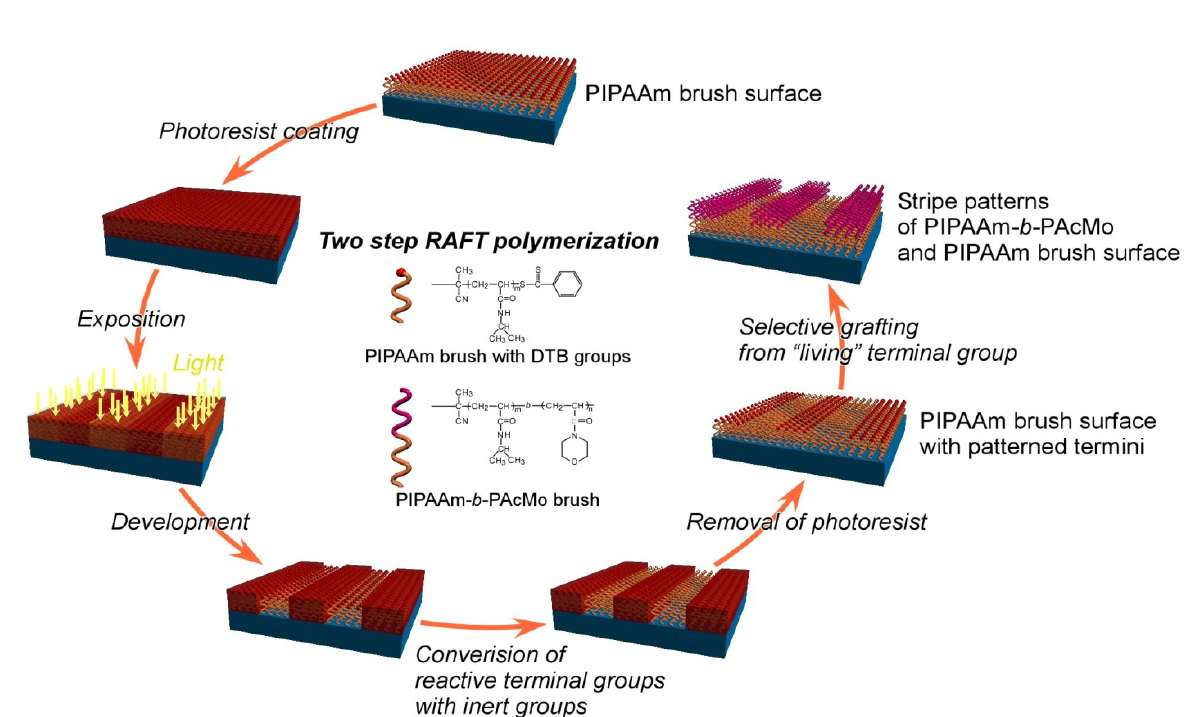
Figure 11. Schematic illustration of preparing a micropatterned temperature-responsive polymer brush surface via two-step reversible addition-fragmentation chain transfer radical (RAFT) polymerization. Poly( N -acryloylmorpholine) (PAcMo) segments have been grafted from PIPAAm blocks through reserved dithiobenzoate (DTB)